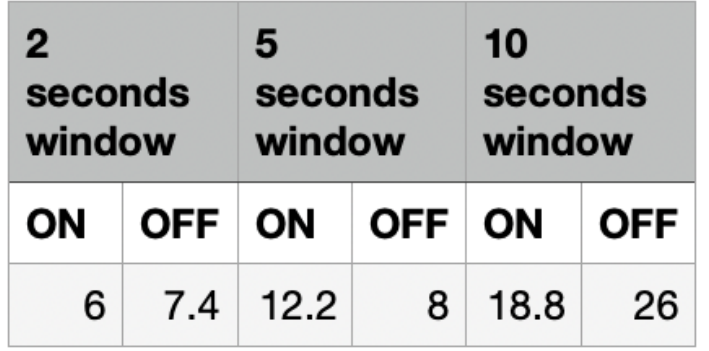
Figure 9. Response